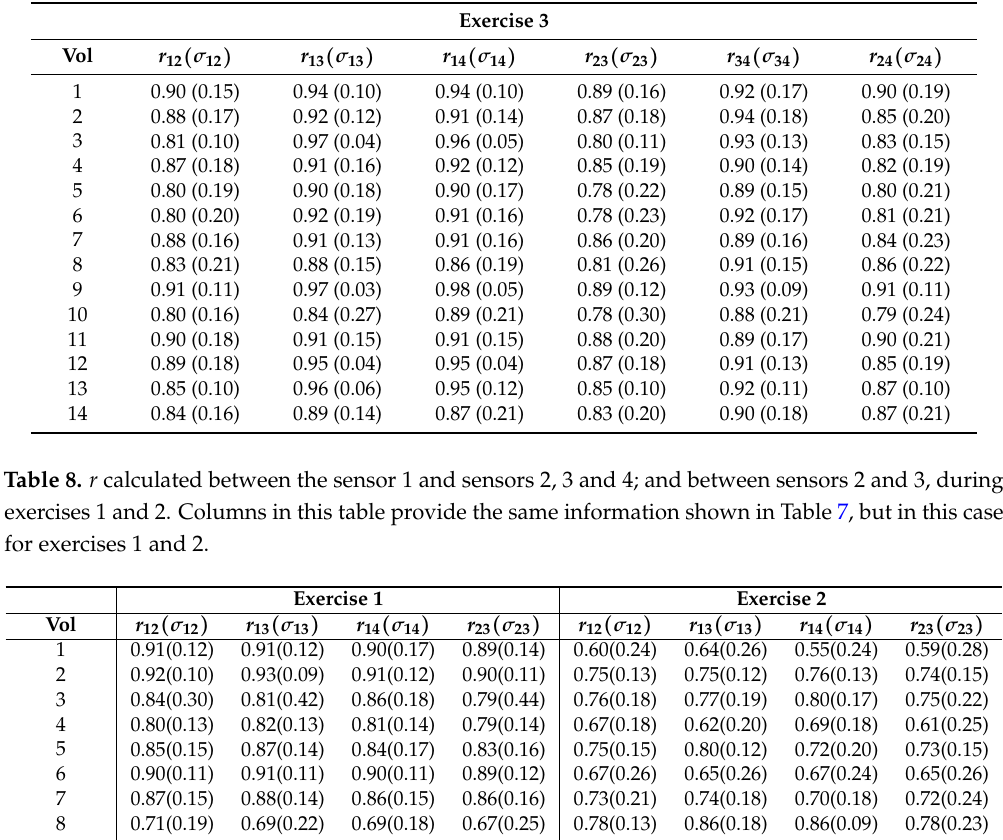
Table 7. r calculated between sensor 1 and sensors 2, 3 and 4 during exercise 3. Parameter r 12 is the average of r calculated between the signals S ω 1 and S ω 2 over all the movements that each volunteer performed to complete the exercise 3; ( σ 12 ) is the standard deviation of these calculations. r 13 ( σ 13 ) , gives the same information as previous column, but correlation was performed between sensors 1 and 3. r 14 ( σ 14 ) , In the same way as the previous two, brings the information regarding correlation between sensor 1 and 4. Finally, r 23 ( σ 23 ) shows behavior of the combination thumb-index (for exercise 3, it brings information regarding tweezers manipulation).